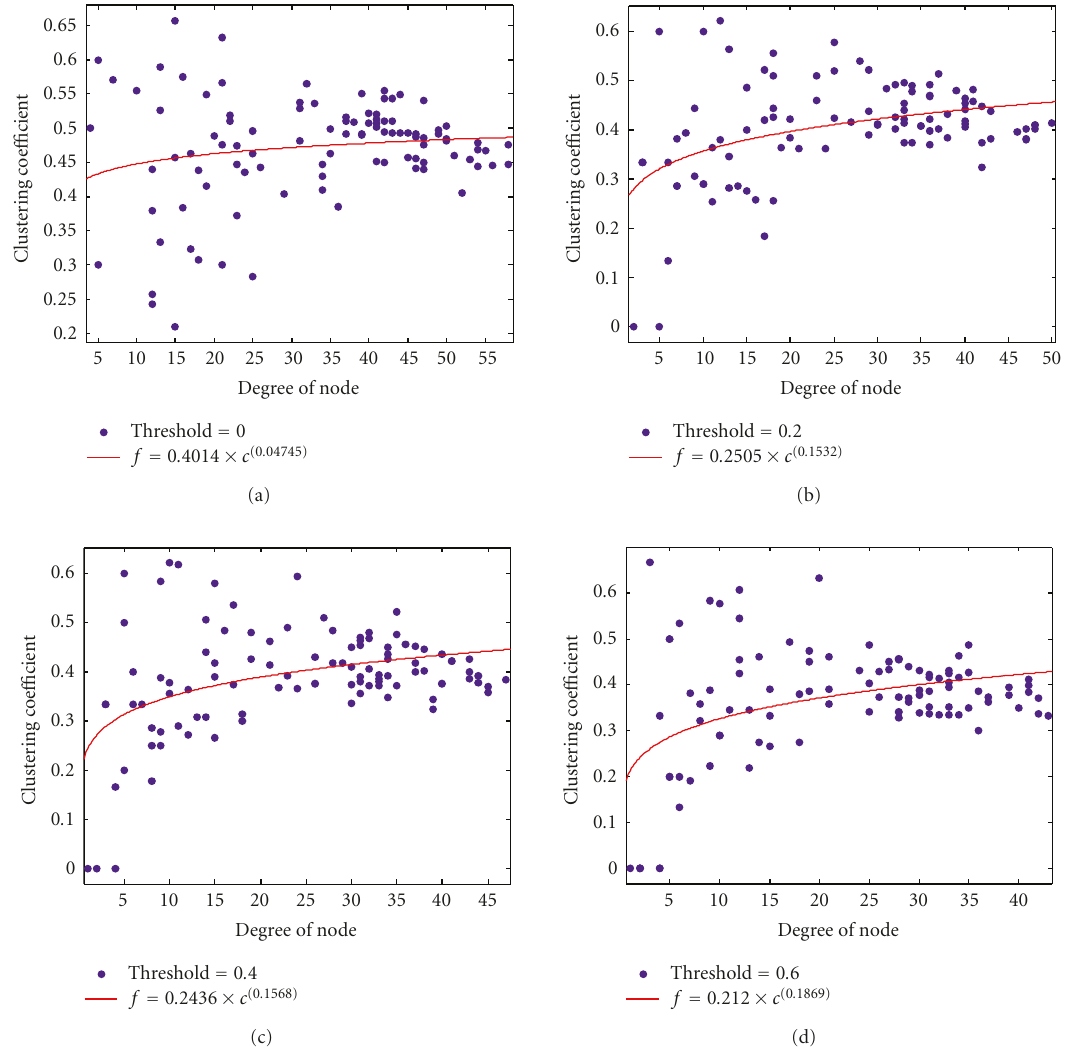
Figure 17: Power law for distribution of clustering coe ffi cient versus degree of nodes: dataset B.